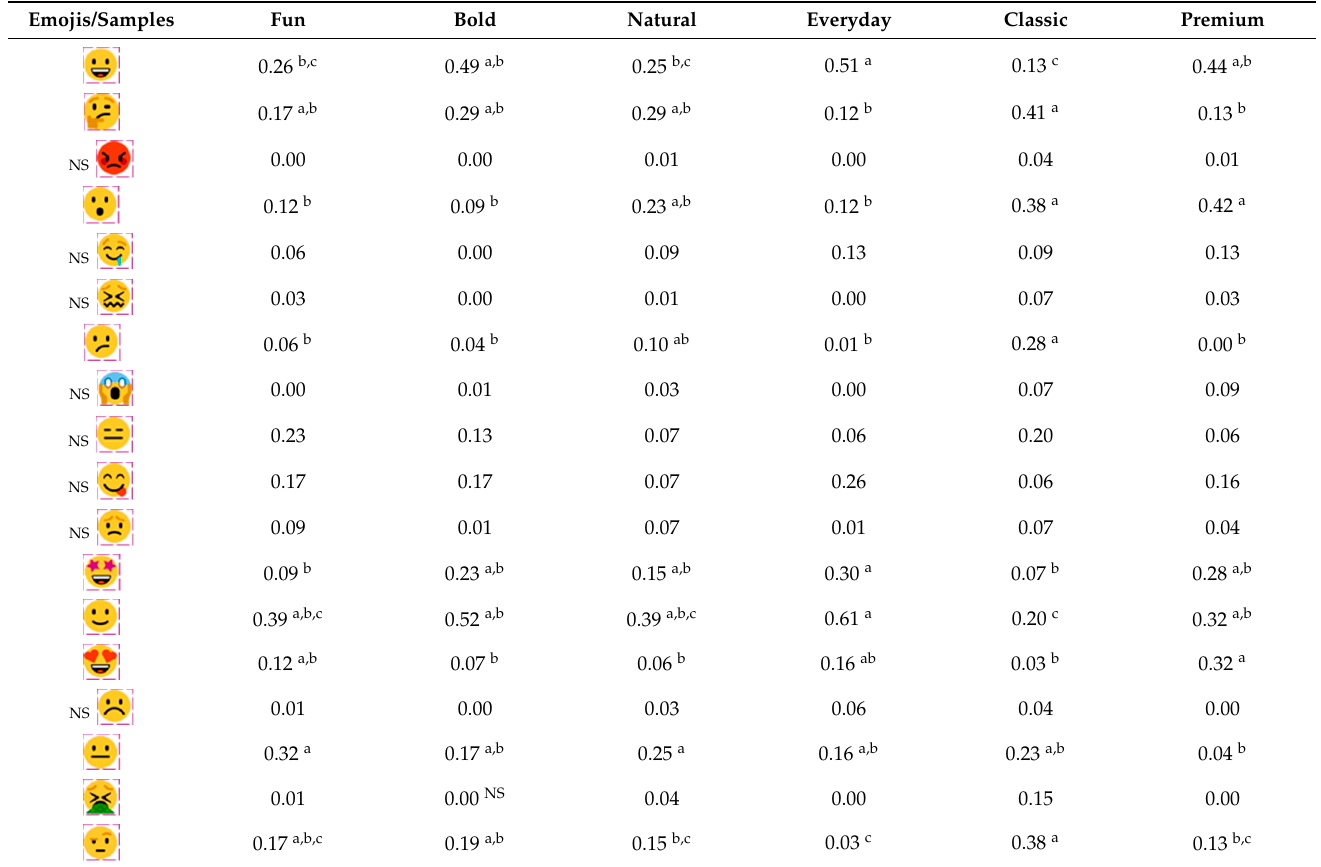
Table 3. Attributes obtained from the participants’ video analysis for emotional